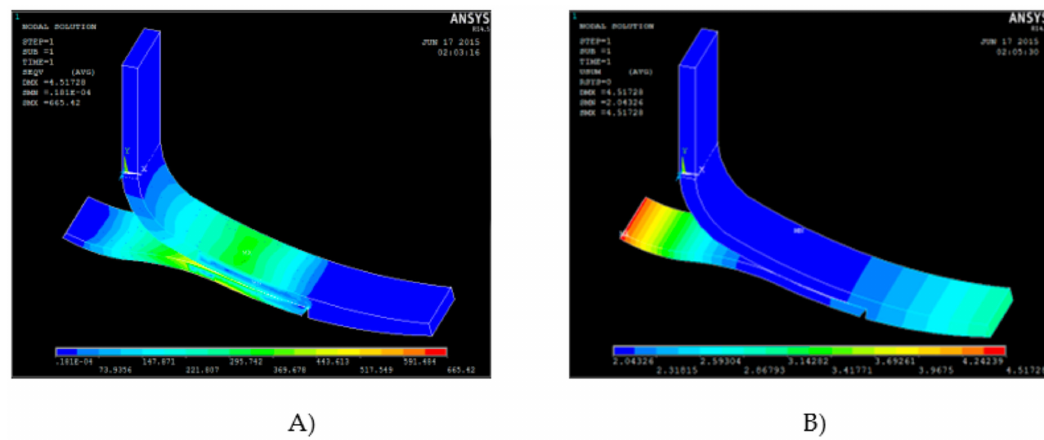
Figure 21. Case 3.1: Numerical analysis of MH. ( A ) Stress. ( B )